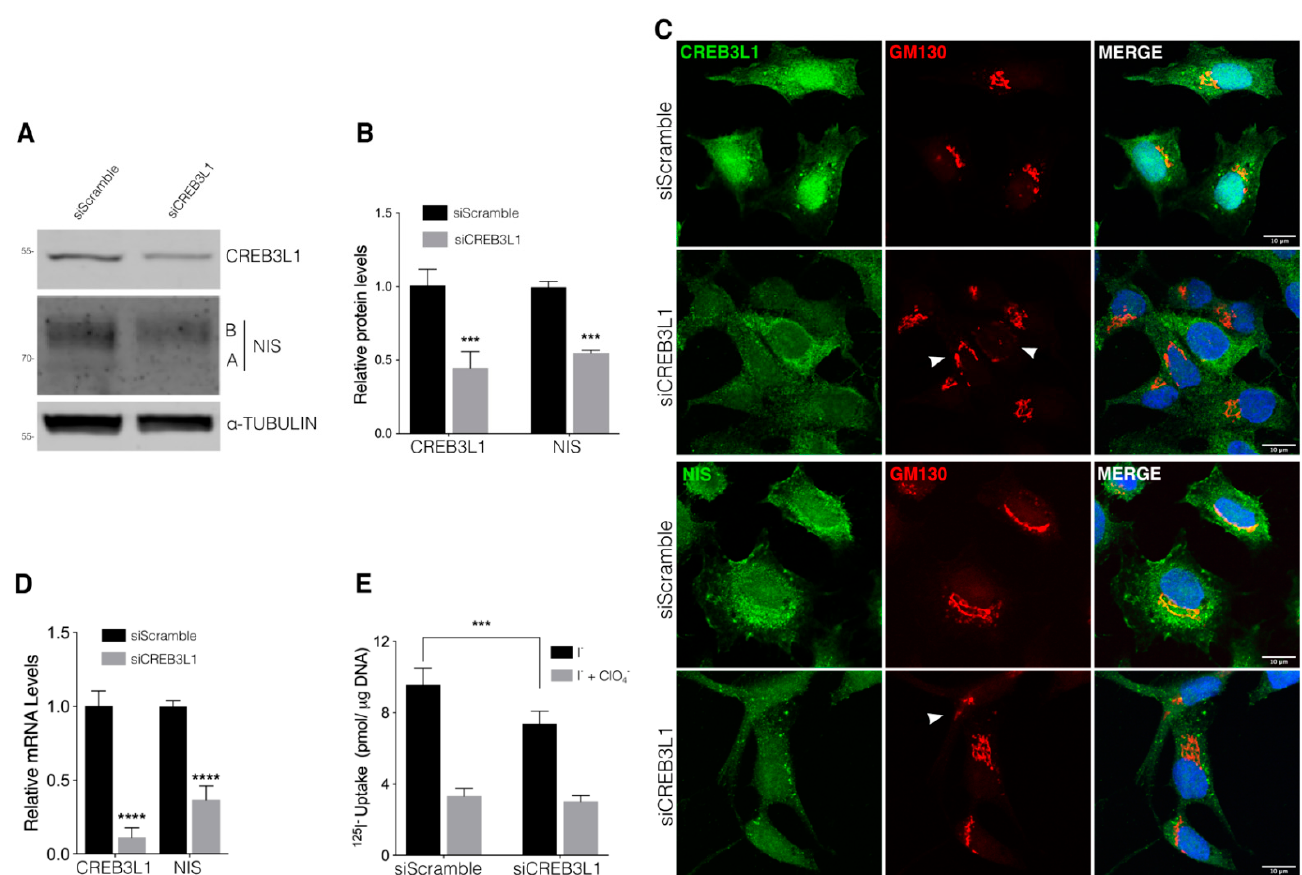
Figure 3. CREB3L1 knockdown decreases NIS expression. ( A ) Western blot with antibodies against CREB3L1 and NIS of lysates from the FRTL-5 cells transfected with siScramble or siCREB3L1 at 48 or 72 h. Tubulin was used as the loading control. ( B ) Densitometric quantification of the proteins in A normalized to α -tubulin. The values represent the fold change relative to the protein levels in the siScramble condition (set as 1). The results are expressed as the means ± SEM of three independent experiments (*** p < 0.001). ( C ) Confocal immunofluorescence analysis of the FRTL-5 cells transfected with siScramble or siCREB3L1 for 72 h stained against either CREB3L1 or NIS (green) and GM130 (red). Arrowheads in the GM130 panels indicate disruption of the Golgi phenotype. The nuclei were labeled with Hoechst 33258. ( D ) Quantification of the CREB3L1 and NIS mRNA levels by means of qPCR performed with total RNA from the FRTL-5 cells transfected with siScramble or siCREB3L1 for 72 h. The results are normalized to the levels of β -actin expressed according to the 2 − ∆∆ Ct method relative to the control levels (set as 1). The results are expressed as the means ± SEM of three independent experiments (**** p < 0.0001). ( E ) 125 I-iodide transport assays assessing iodide accumulation in siScramble or siCREB3L1-transfected cells under growth conditions. The cells were incubated with 20 µ M iodide in the absence (black bars) or presence (gray bars) of 80 µ M K-perchlorate. The data are expressed in pmol of 125 I-iodide/ µ g of DNA. The results are expressed as the means ± SEM of three independent experiments (*** p <